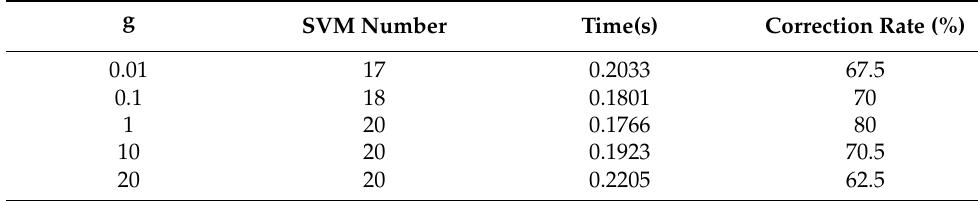
Table 3. Effect of penalty function ( g ) on SVM bi-classifier accuracy.